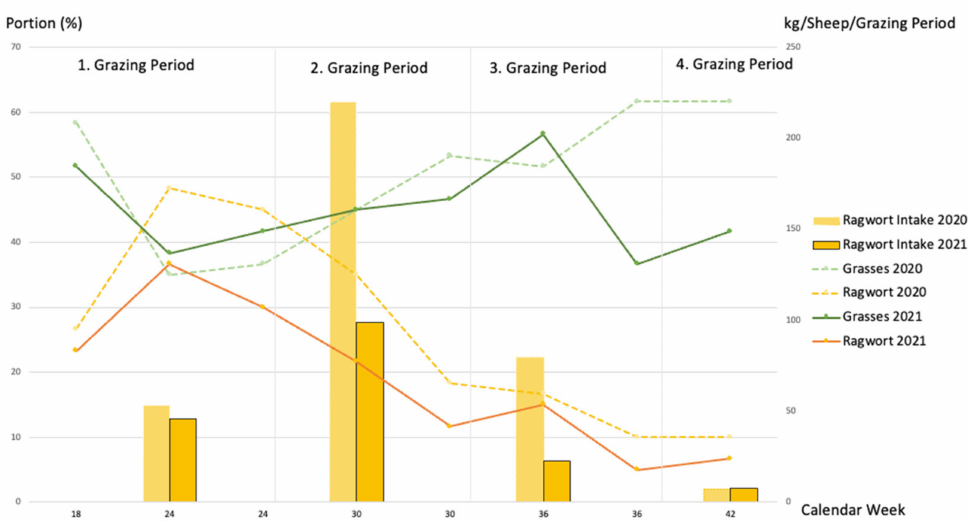
Figure 2. Average yield proportions of grasses and ragwort (lines; units left ordinate) vs. ingested ragwort (bars; units right ordinate) in kg (OS) per sheep and grazing period (=45 days = six weeks) in 2020 and 2021. Data obtained from grazing plots.